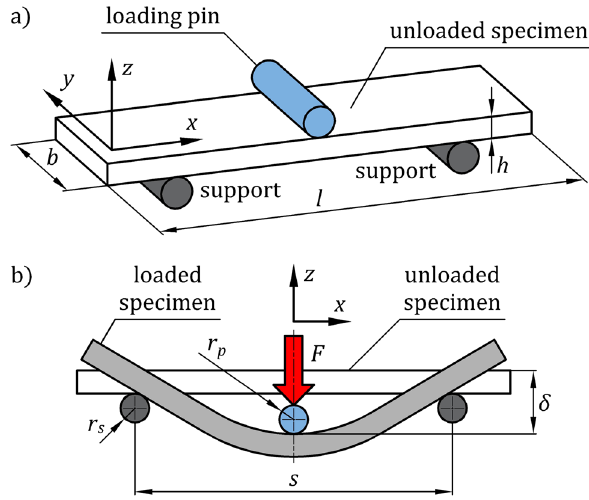
Figure 1: ( a ) Shape and dimensions of typical fl exure specimen and ( b ) three - point fl exure loading con fi